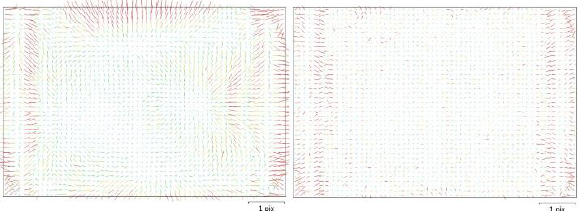
Figure 12. Residual plots from Agisoft Metashape B and B+F96 for Sony (data set 6); vector scale